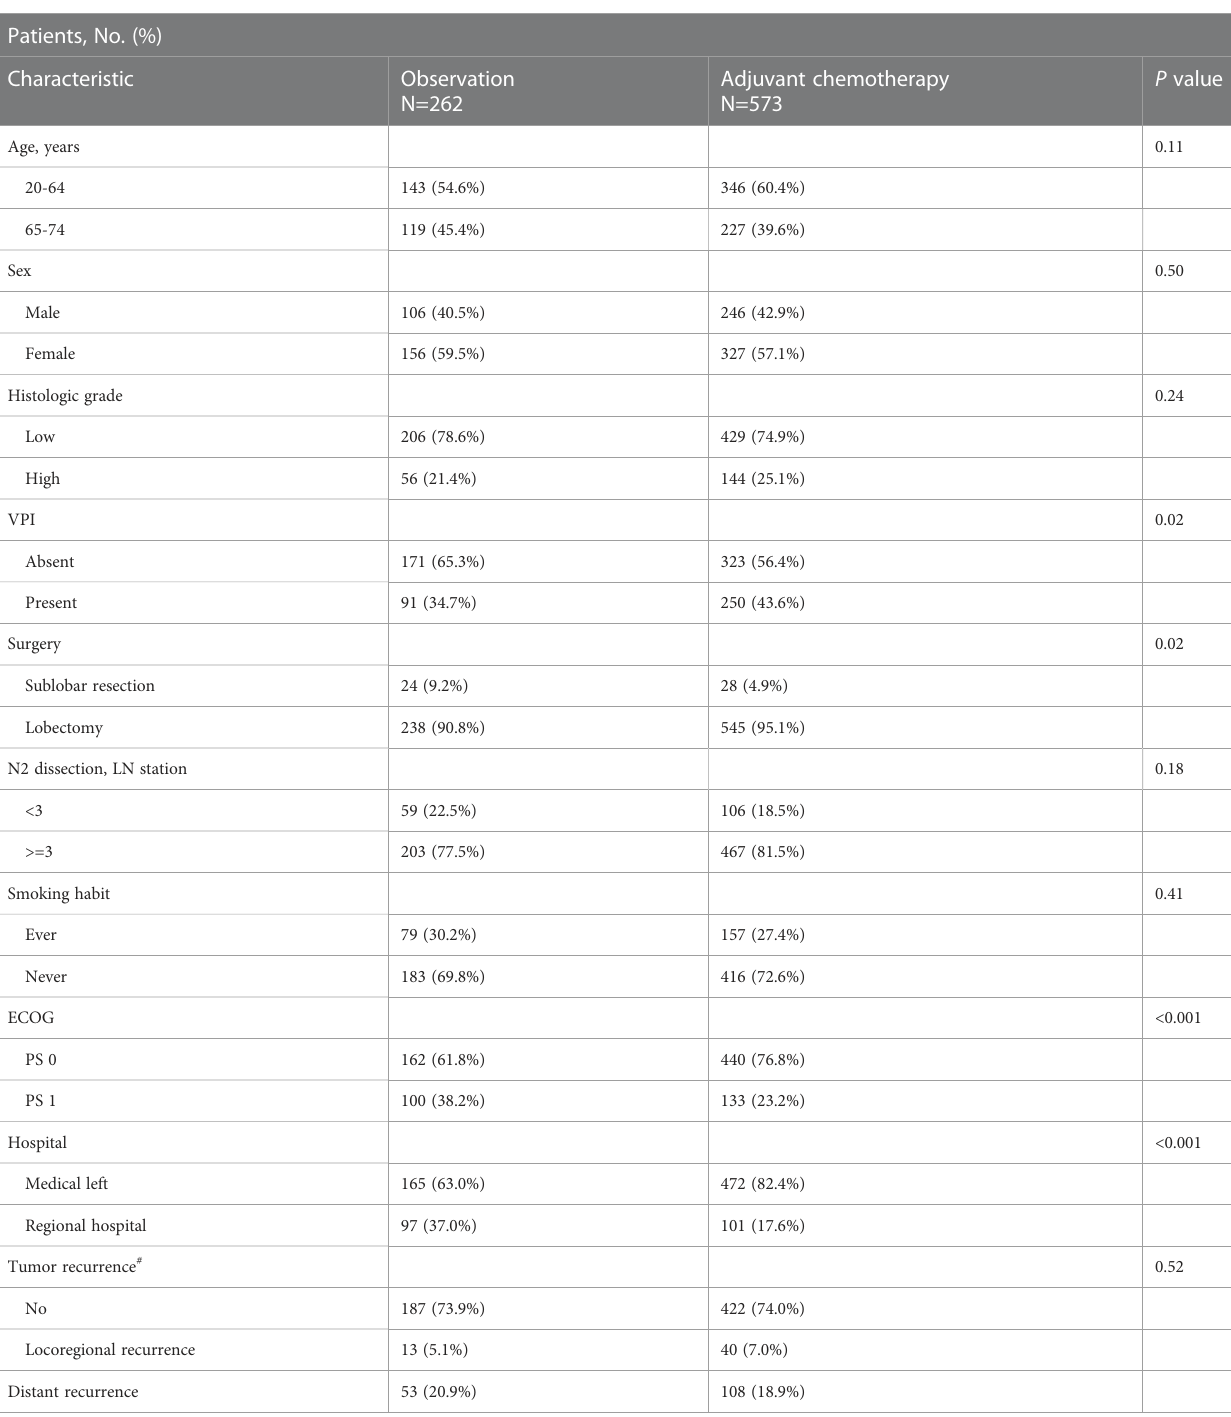
TABLE 1B Group 2: tumor >3 cm, but <= 4cm Patients, No.